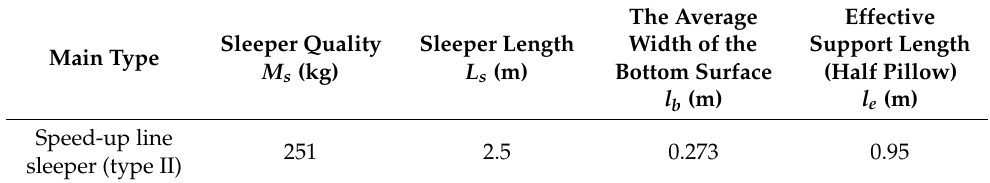
Table 1. Basic parameters of sleeper.